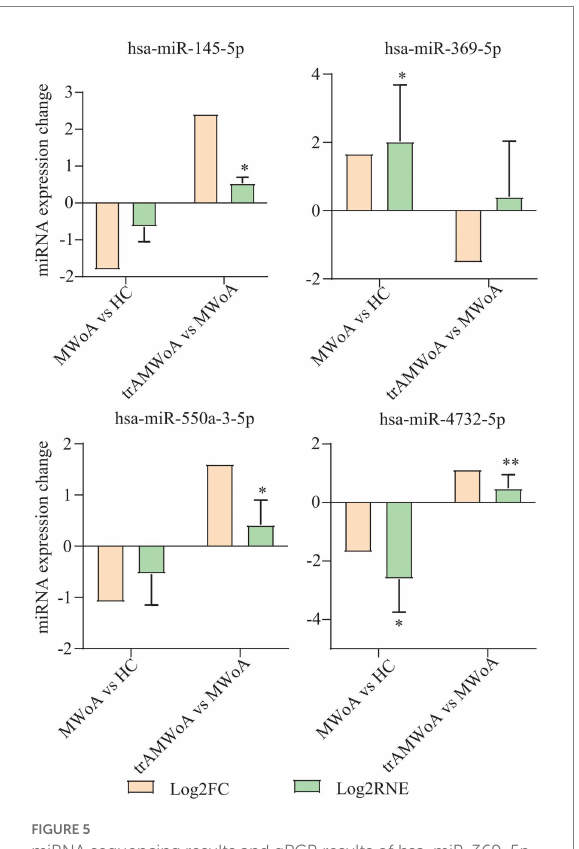
FIGURE 5 miRNA sequencing results and qPCR results of hsa-miR-369-5p, hsa-miR-4,732-5p, hsa-miR-550a-3-5p, and hsa-mir-145-5p. MWoA, migraine without aura; HC, healthy control; trAMWoA, migraine without aura patients receiving true acupuncture treatment; log2 FC, log2 fold change; log2 RNE, log2 relative normalized expression. * represents p <